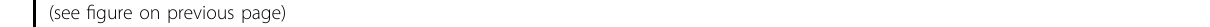
Fig. 7 Effect of EHF-SF-L285. A ZEB1 promoter activities were determined by luciferase assays (top panel), followed by IB (bottom panel), after cells had been transfected with the indicated plasmids. Each value represents the mean ± s.d. of triplicate determinations from a representative experiment. Similar results were obtained in at least three independent experiments. B, C, D, E, F , and G HSC4 and OTC04 cells were infected with either control (cont.) or fl ag-tagged EHF-SF-L285P and subjected to IB ( B ), motility assays ( C ), chemoresistance assays ( D ), and proliferation assays ( E ). HSC4 cells infected with lentiviruses carrying either control ( n = 7) or fl ag-tagged EHF-SF-L285P ( n = 8) were injected into the periosteal region of the parietal bone in mice. Five weeks later, mice were sacri fi ced and specimens were prepared after decalci fi cation. Typical histology in hematoxylin and eosin staining are shown ( F ), followed by statistical analysis ( G ). T tumor, B bone, F fi brous tissue. p values were determined by Student ’ s t -test. * p < 0.01. H Human osteosarcoma 143B-Luc cells infected with either control ( n = 5) or EHF-SF-L285P ( n = 5) were injected intravenously into the lateral tail vein of mice. After mice were anesthetized with iso fl urane on day 14, D-luciferin potassium salt was injected intravenously, followed by measurement of the emission intensity using the IVIS Lumina imaging system (left) and quanti fi cation analysis